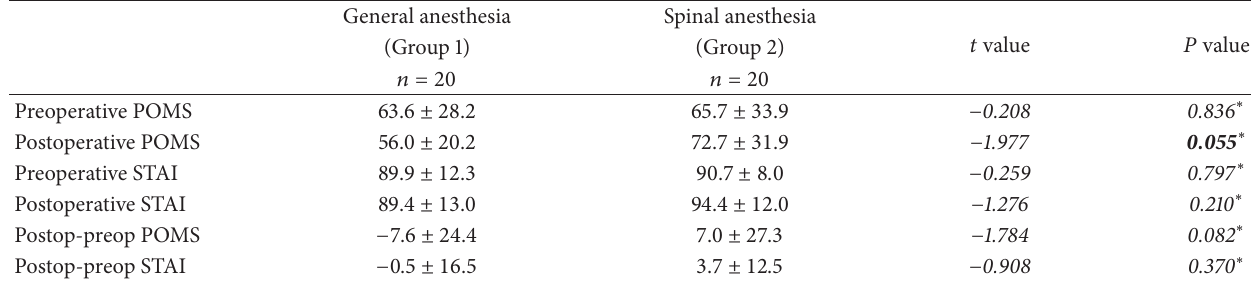
Table 3: Comparison of anesthetic procedures on psychological